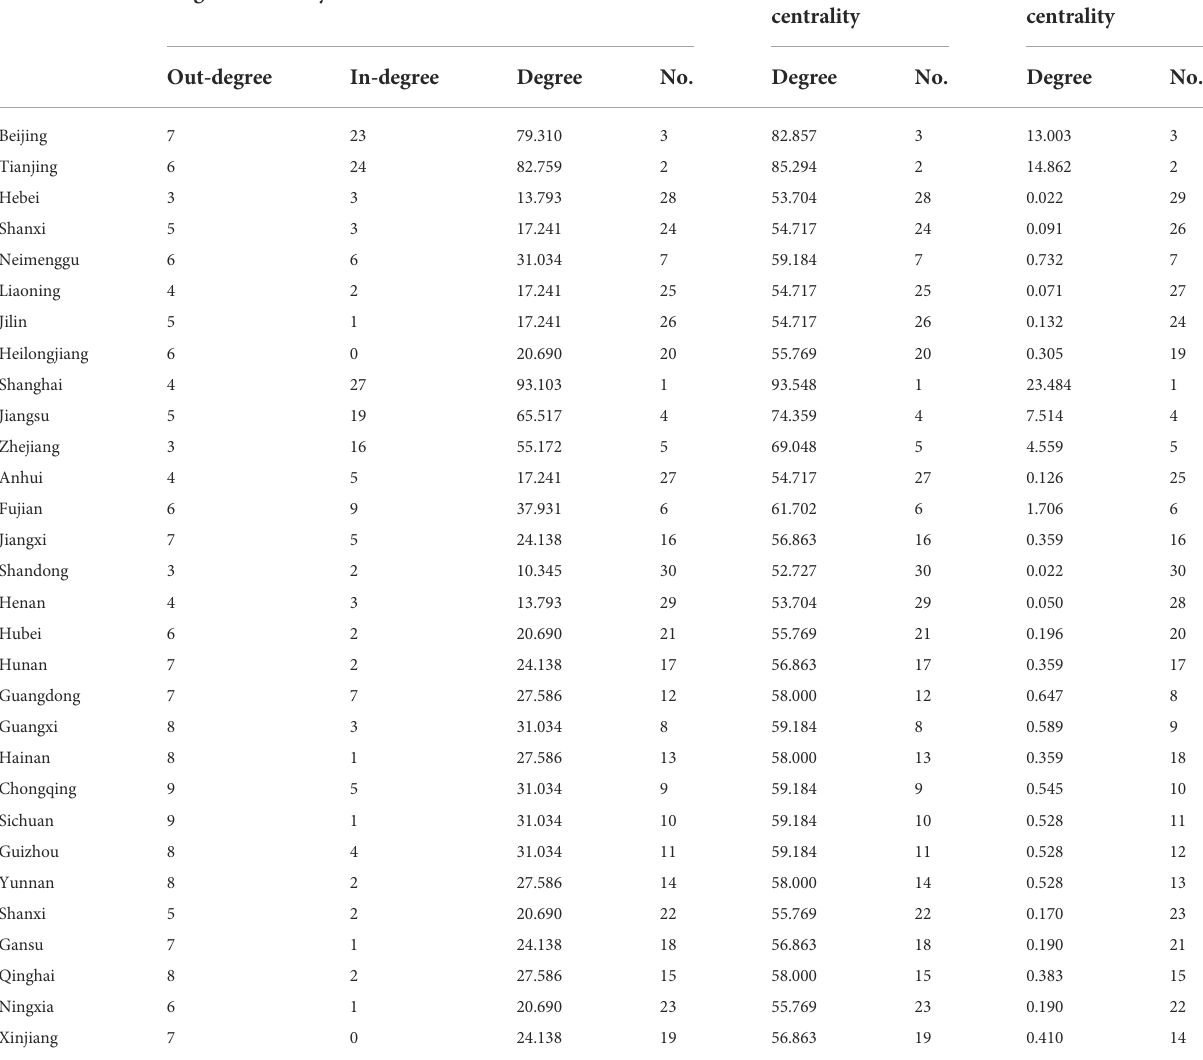
TABLE 4 Centrality of spatially linked networks of ALTFP in China in 2020.